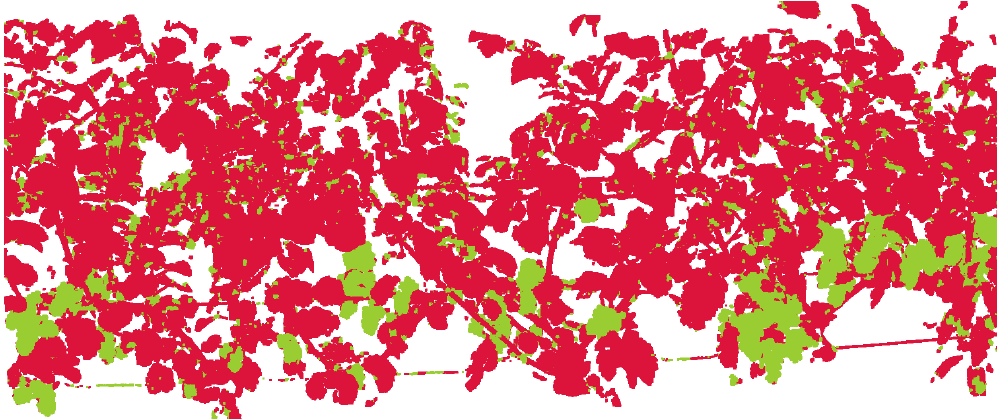
Figure 10. Classified point cloud after label smoothing. Former heterogeneous regions are now homogeneous. Small regions of misclassified points are corrected. Branches lying in between grape bunches are classified